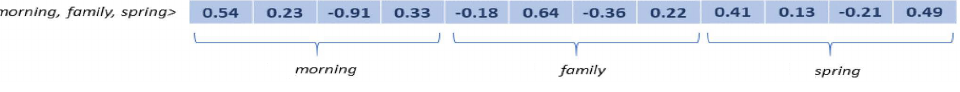
Figure 2. A context situation is a concatenation of the condition